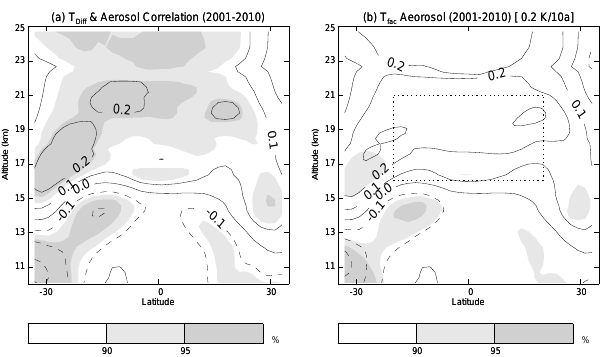
Figure 7. Same as Fig. 3 but for the impact of stratospheric aerosols by comparing the W_L103 and the W_Aerosol experiments. Con- tour interval is (a) 0.1 and (b) 0.1Kdecade − 1 . The temperatures in the W_L103 run were calculated from a three member ensemble